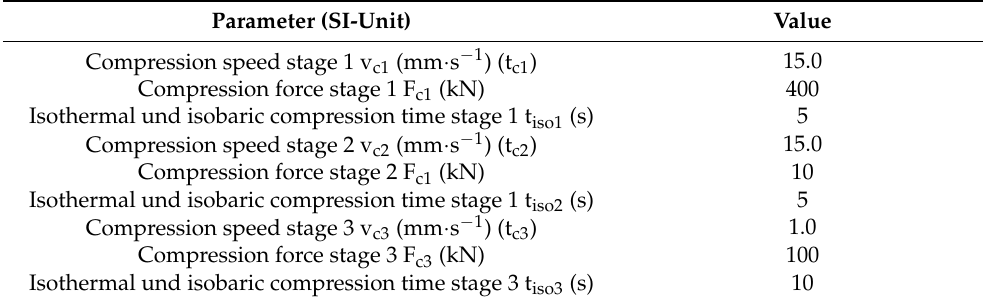
Table 3. Parameter setting of the multi-stage ICM-DT at the different compression